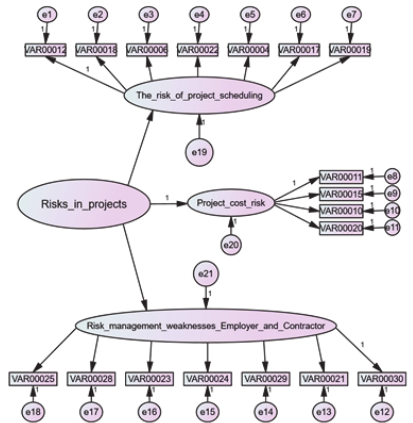
Fig. 3. The results of the implementation of structural equation